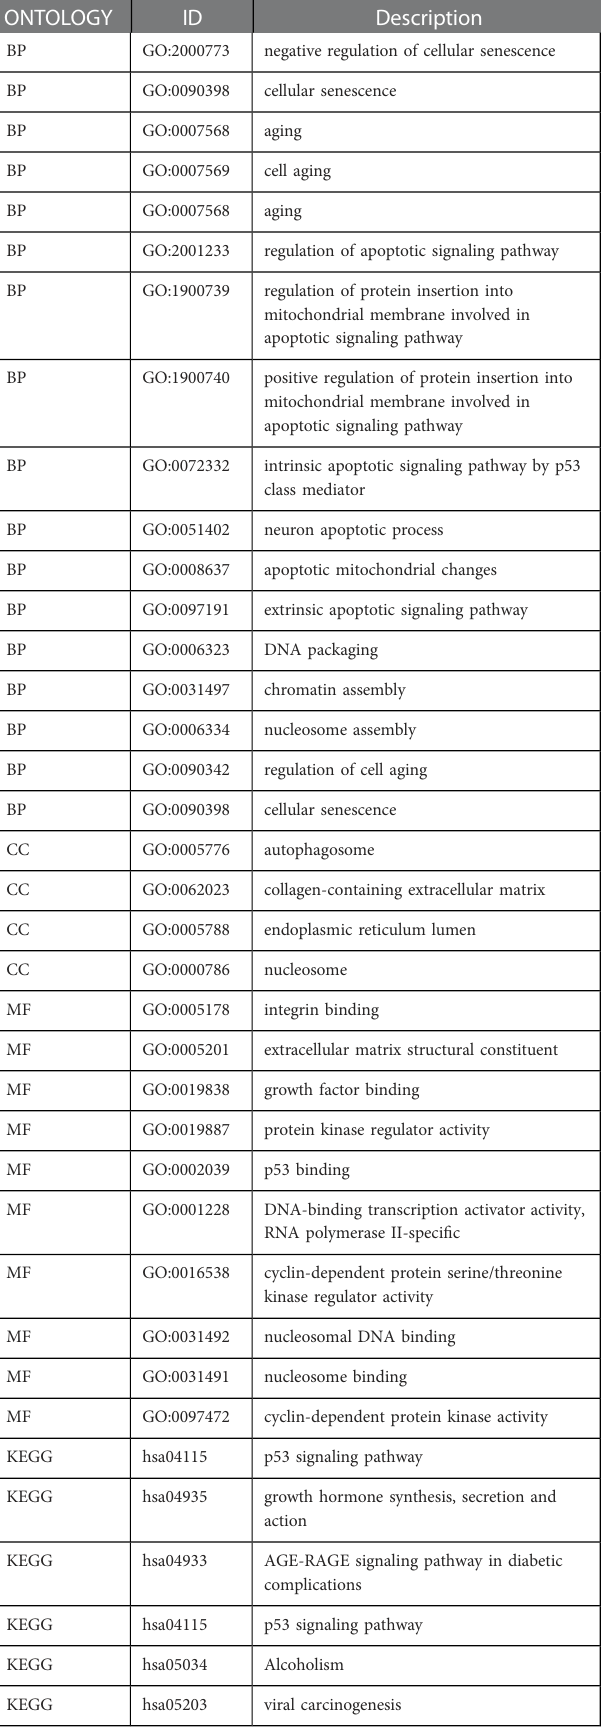
TABLE 1 GO/KEGG analysis annotations of module genes. ONTOLOGY